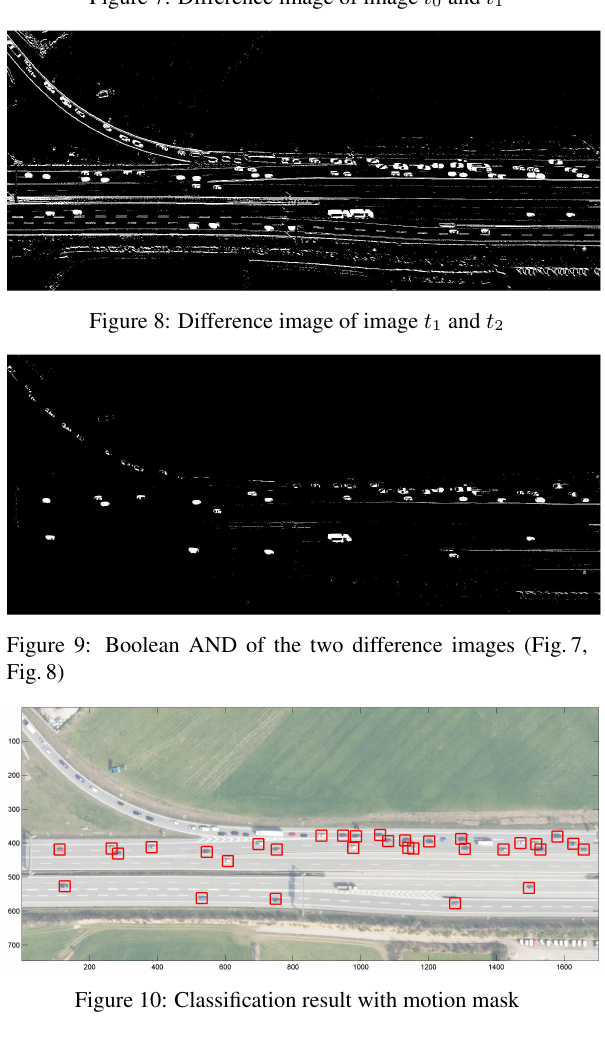
Figure 7: Difference image of image t 0 and t 1